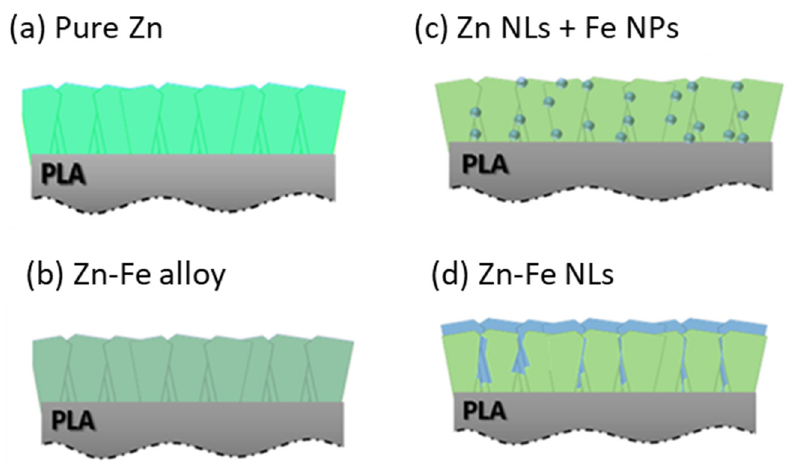
Figure 1. Diagram of the different morphologies produced by classical magnetron sputtering and hybrid magnetron sputtering with a cluster gun: ( a ) pure Zn; ( b ) Zn-Fe alloy; ( c ) Zn NLs + Fe NPs; and ( d ) Zn-Fe NLs.